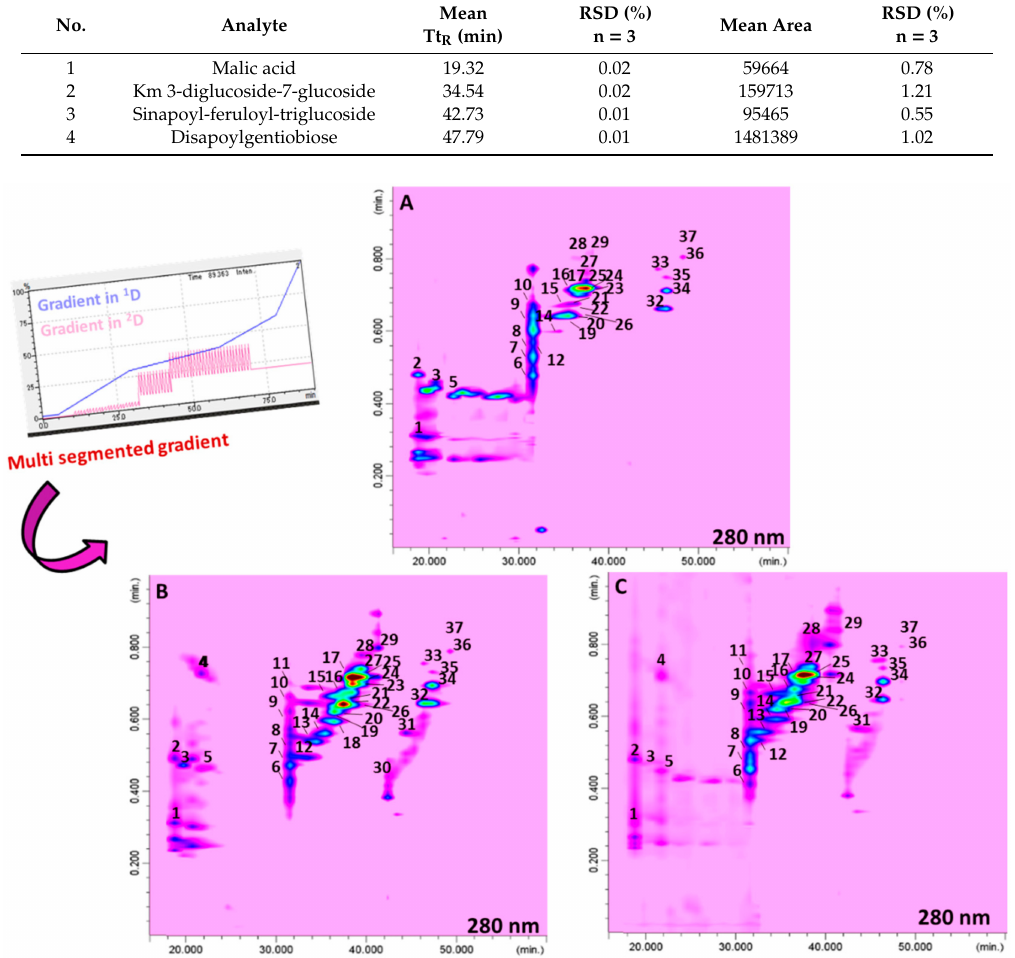
Table 1. Repeatability data calculated from four selected peaks of the RP-LC × RP-LC plots shown in Figure 2. RSD: Relative Standard Deviation. Km: Kaempferol.